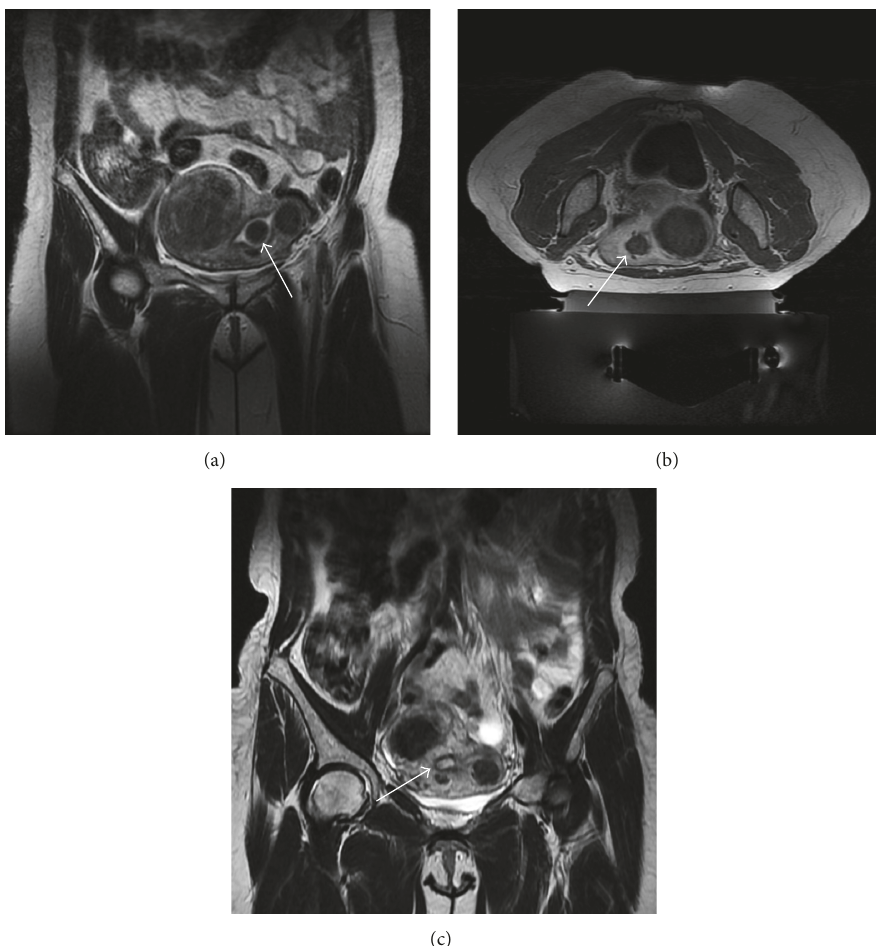
Figure 5: Case 3 : (a) screening coronal T2-w showing the bigger intramural fibroid on the right wall of the uterus, the small intracavitary submucosal fibroid on the mid left (white arrow), and one more small intramural fibroid on the left wall of the uterus; (b) axial T1-w acquired after intravenous injection of paramagnetic contrast medium acquired at the end of the treatment showing treated fibroids as nonenhancing round lesions (white arrow on the small intracavitary submucosal fibroid); (c) in a follow-up MRI, the small intracavitary submucosal fibroid was no more appreciable; the white arrow shows the “empty” uterine cavity after spontaneous vaginal expulsion.